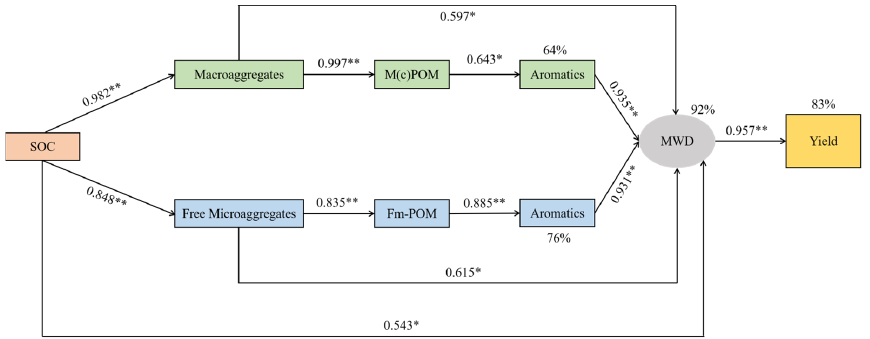
Figure 9. Structural equation model by using OC contents of macroaggregates, free microaggregates, M(c)POM, and Fm-MOM fractions, plus with the amounts of aromatic substances as predictors of soil aggregate stability under 7-year manure addition ( p = 0.114, χ 2 /df = 1.63, and GFI = 0.927). The numbers next to the arrows indicate the standardized path coefficients, and the solid arrows represent the positive paths, * and ** indicates significant level at p < 0.05 and p < 0.01, respectively. The percentage of variance for each variable presents next to the box for the corresponding variable. The specific meanings of organic matter and organic carbon fractions with abbreviations are presented in Table